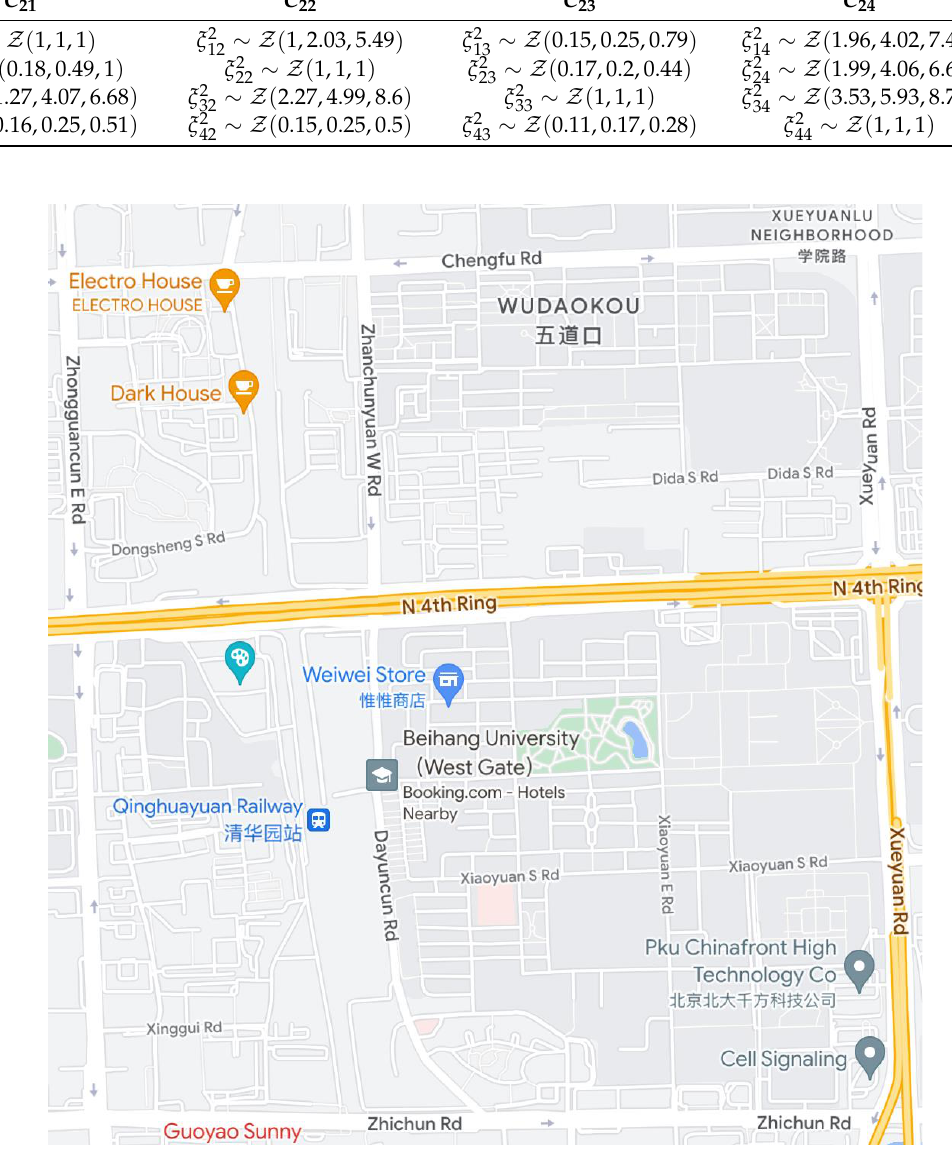
Figure 5. The regional transportation network under study shown in Google Maps.